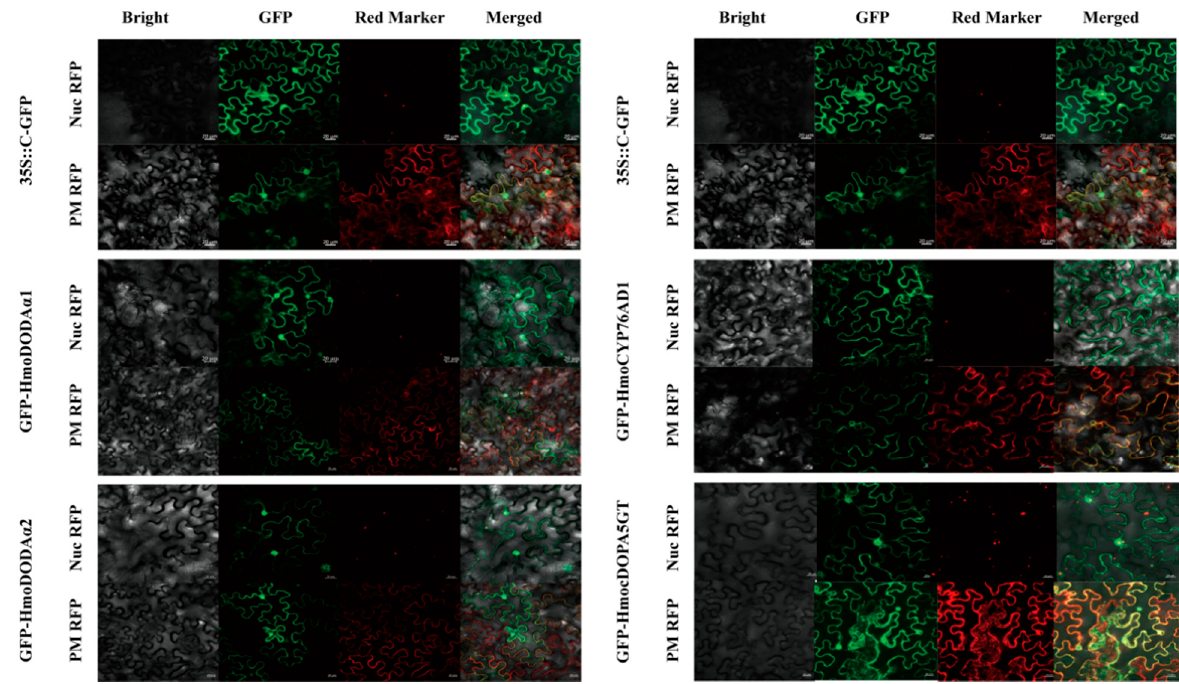
Figure 4. Subcellular localization of HmoDODA α 1 , HmoDODA α 2 , HmoCYP76AD1 and HmocDOPA5GT . Every GFP con- struct and nucleolus-localized RFP marker or dual nucleus and cytoplasm RFP marker were co-transformed to leaf of N. benthamiana . Nuc RFP, Nucleolus-localized RFP marker (pAN95-At1g22590); PM RFP, Plasma membrane RFP marker (pAN-At5g19750); GFP-Gene, GFP tagged at the C-terminus of the gene; Bar = 20 μ m.